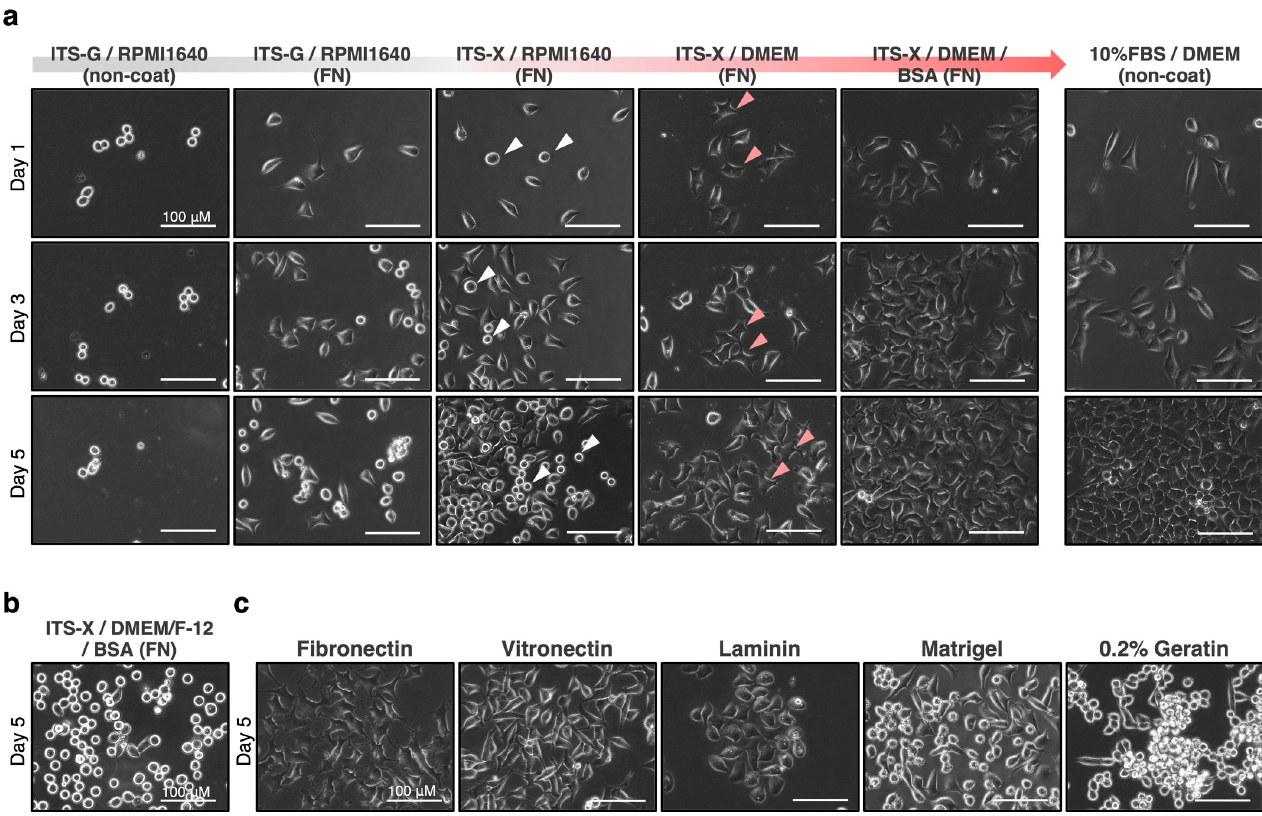
Fig 1. Optimization of novel serum-free condition on HeLa cells. a, Representative images of cells in each culture condition. In screening for novel serum- free condition, 2x10 4 cells of HeLa cell (human cervical cancer cell line) maintained in 10% FBS/ DMEM were seeded onto each serum-free media condition. Combinations of media composition and extra-cellular matrix are shown. Improving stepwisely from RPMI-G with replacing the media composition resulted in establishment of the ITS-X/ DMEM/ BSA on fibronectin-precoated well (called as DA-X condition), which significantly improved cell adhesion, pseudopodia elongation, or proliferation. Non-coat, without any pre-coating. White and pink arrowheads indicate cells with losing attachment and cells with firm elongated pseudopodia, respectively. FN, fibronectin-coated. Scale bar, 100 μ m. b, Representative images of cells cultured in DMEM/ Ham’s F-12-based medium with ITS-X/ BSA on fibronectin-precoated well. c, Representative images of cells in comparison of effect of extracellular matrix. 2x10 4 cells of HeLa cell maintained in 10% FBS/ DMEM were seeded onto a pre-coated well with each extracellular matrix. Regarding to cell adhesion, pseudopodia elongation, or proliferation, fibronectin was shown as much better than the other extracellular matrix. The effect of vitronectin was shown as comparable to that of fibronectin in cell adhesion and cell proliferation, but not in pseudopodia elongation. Scale bar, 100 μ m.